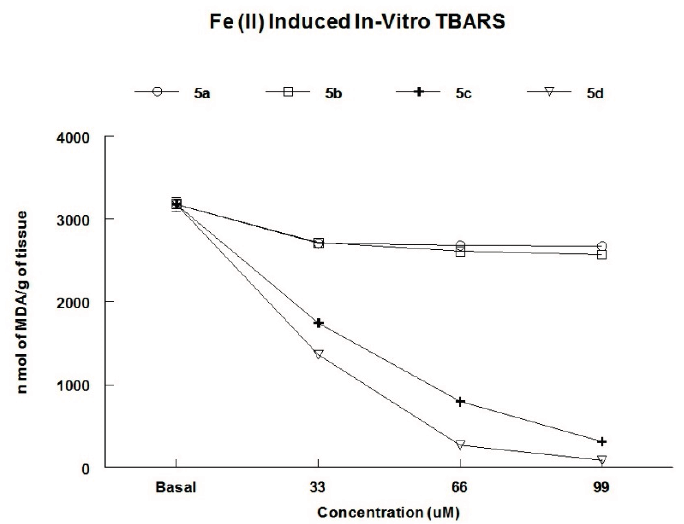
Figure 3. Effect of 2-picolylamide based diselenides 5a – d on Fe (II) induced TBARS formation in low-speed supernatant (S1) from brain homogenate. Fe (II) sulfate at 20 µM was used as pro-oxidant. TBARS are expressed as nmol of MDA/g of tissue. Data are presented as mean ± S.E.M. ( n =